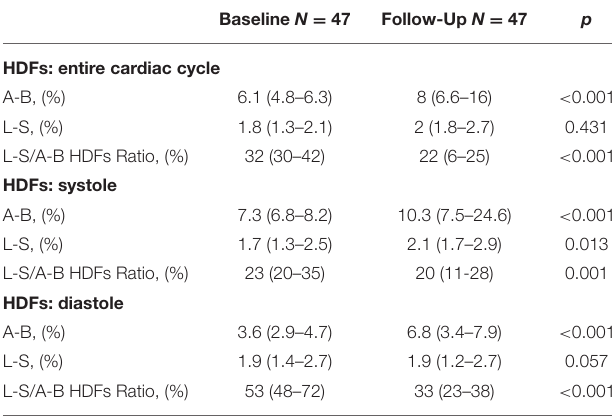
TABLE 4 | Baseline vs. follow up echocardiographic estimated hemodynamic